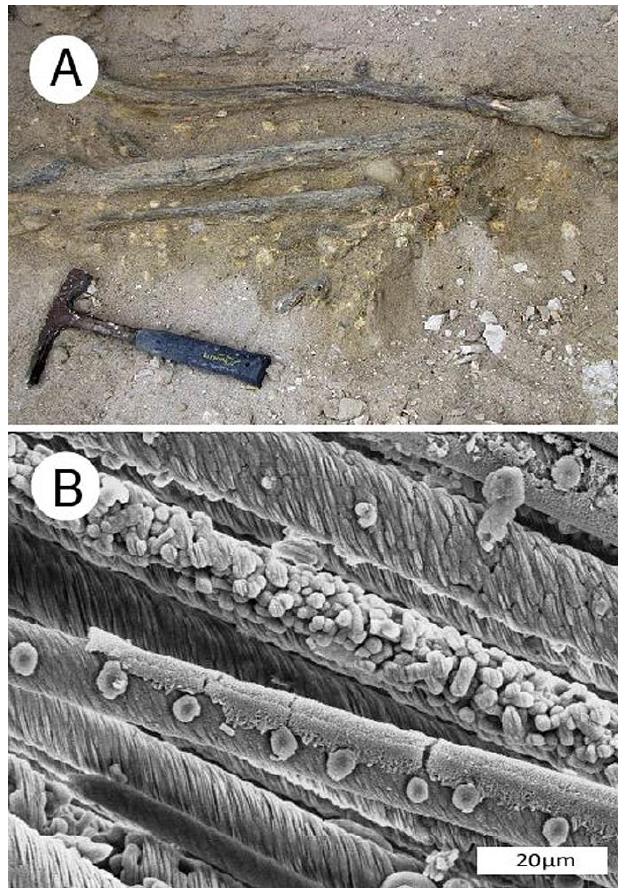
Figure 5. Phosphatized Miocene wood from Bruneau, Idaho, USA. ( A ) Driftwood limbs in lacustrine sediment; ( B ) SEM image showing tracheids mineralized with carbonate fluorapatite. Radial view. Spiral texture characterizes reaction wood, where asymmetric growth occurs in trees growing non-vertically. One tracheid shows circular casts of intertracheid pits, an adjacent tracheid is filled with blocky apatite crystals.